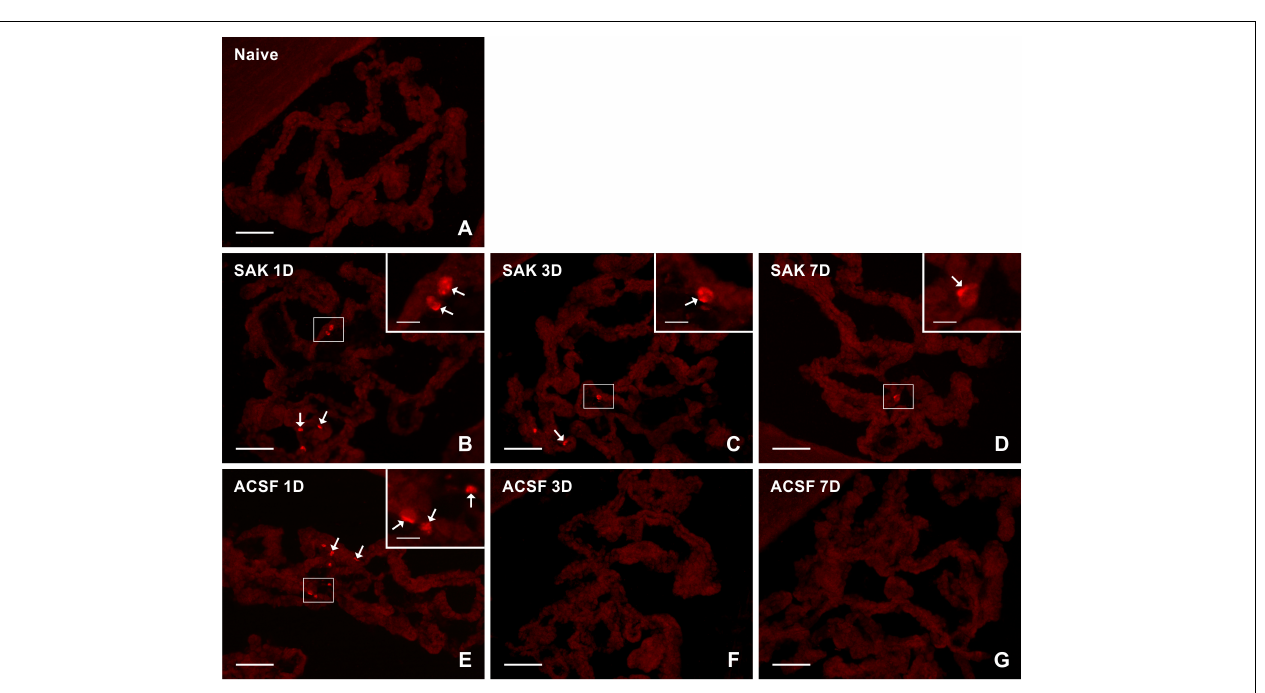
Frontiers in Cellular Neuroscience | www.frontiersin.org